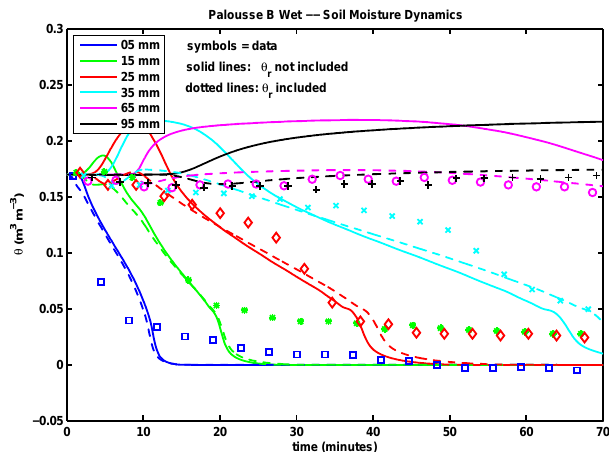
Figure 11. Comparison of measured (symbols) and modeled (lines) soil moisture content during the Palousse B Wet heating experiment. The solid lines are for a model simulation that does not include the dynamic residual soil moisture, θ r ; the dotted lines correspond to a simulation that includes θ r . For this experiment the initial soil moisture, θ in , is 0.17m 3 m − 3